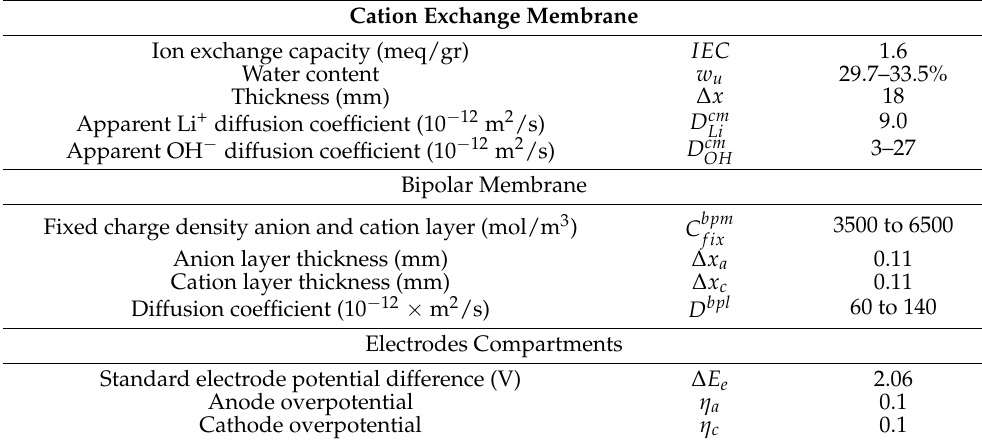
Figure 2. Batch process scheme for LiOH production by BMED. Table 1. Membranes and electrode compartments characteristics used in